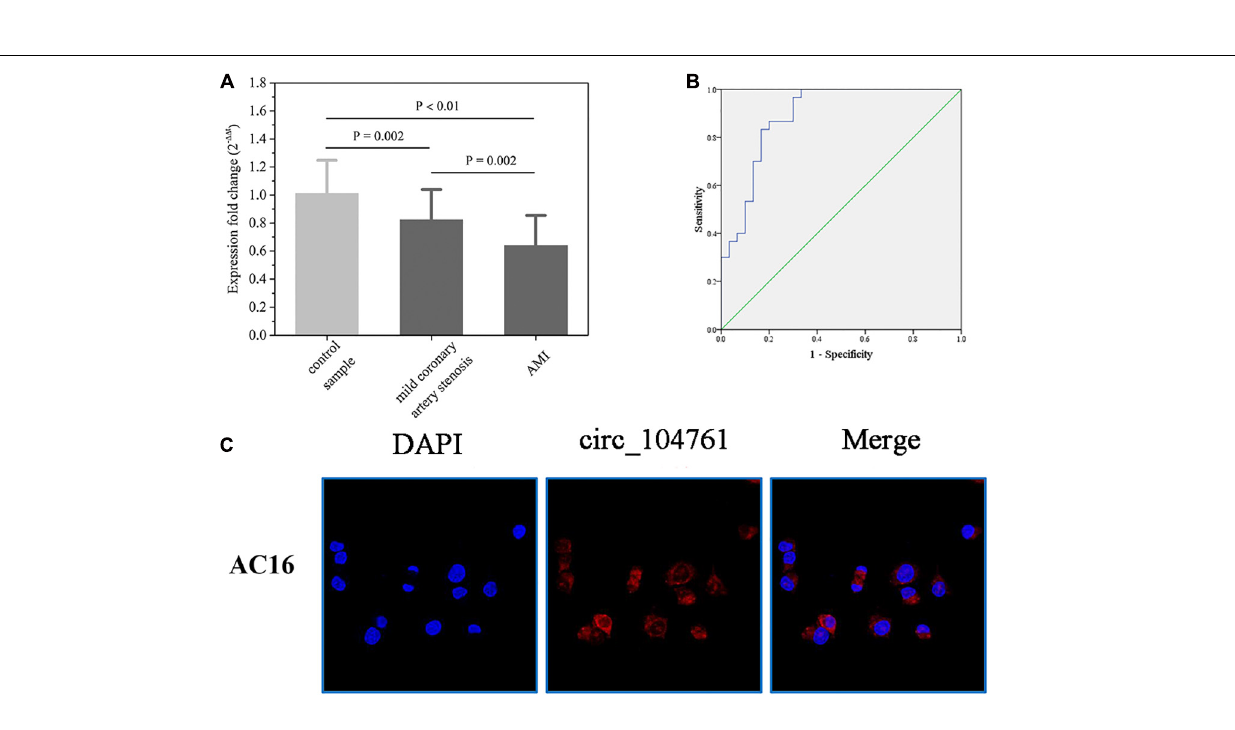
Frontiers in Genetics |